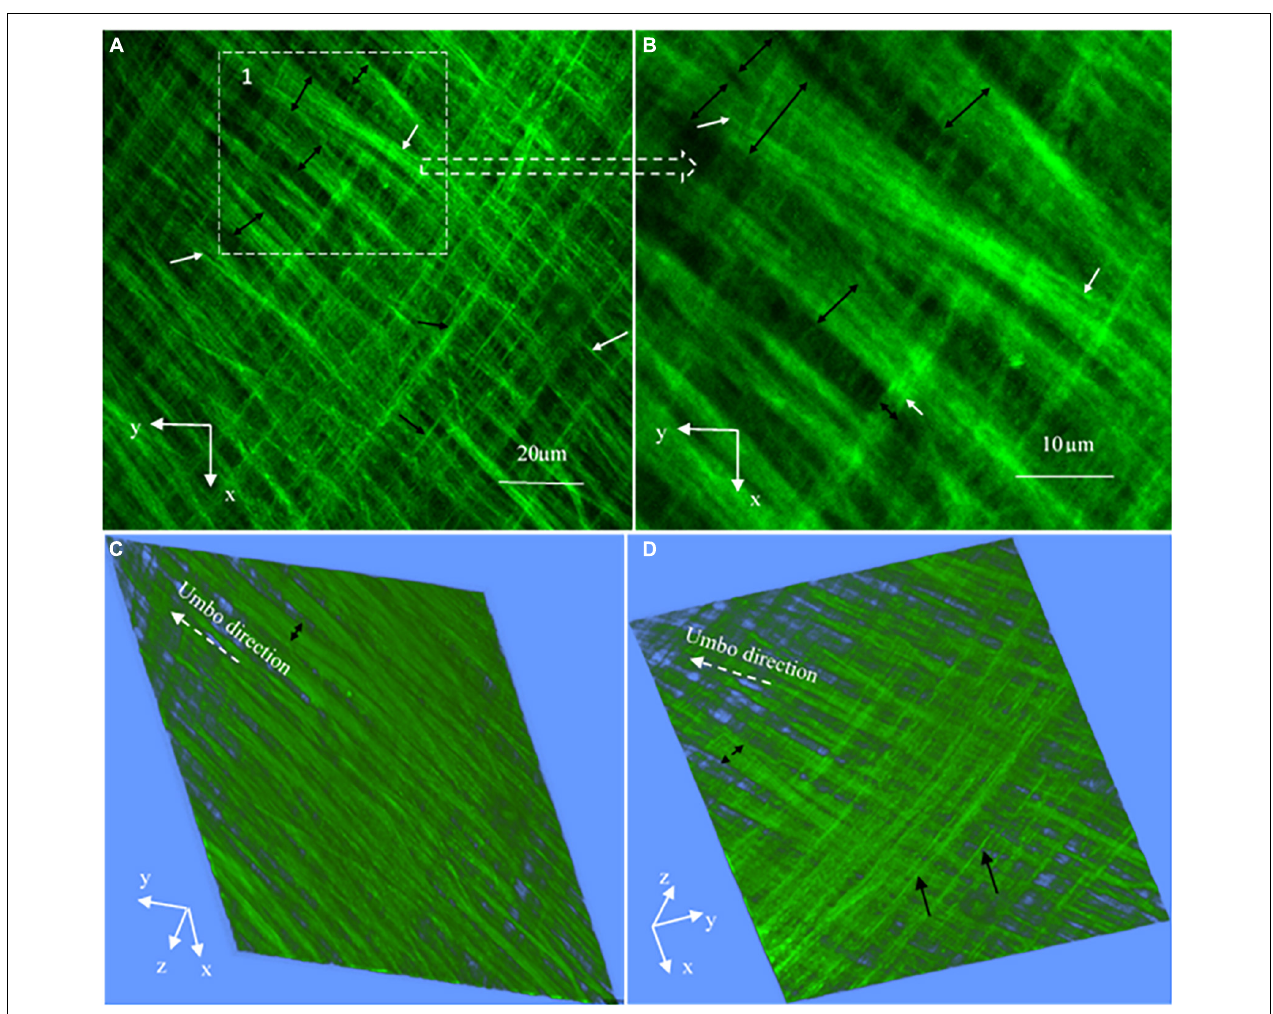
FIGURE 7 | High magnification SHG images (at a 127 × 127 µ m 2 field of the view) at the periphery of the TM pars tensa (approximately at region 1 in Figure 4A ). (A) The high magnification observations verify that the thick collagen fibers (double headed black arrows) of the periphery of the pars tensa are composed of the subclass collagen fibrils in the corresponding radial (white arrows) and circumferential (black arrows) direction. (B) An enlarged image extracted from region 1 of panel (A) shows in more detail that the collagen fibers (black double headed arrows) comprise the subclass collagen fibrils (white arrows). (B,C) The corresponding 3D images in the lateral (C) and medial (D)